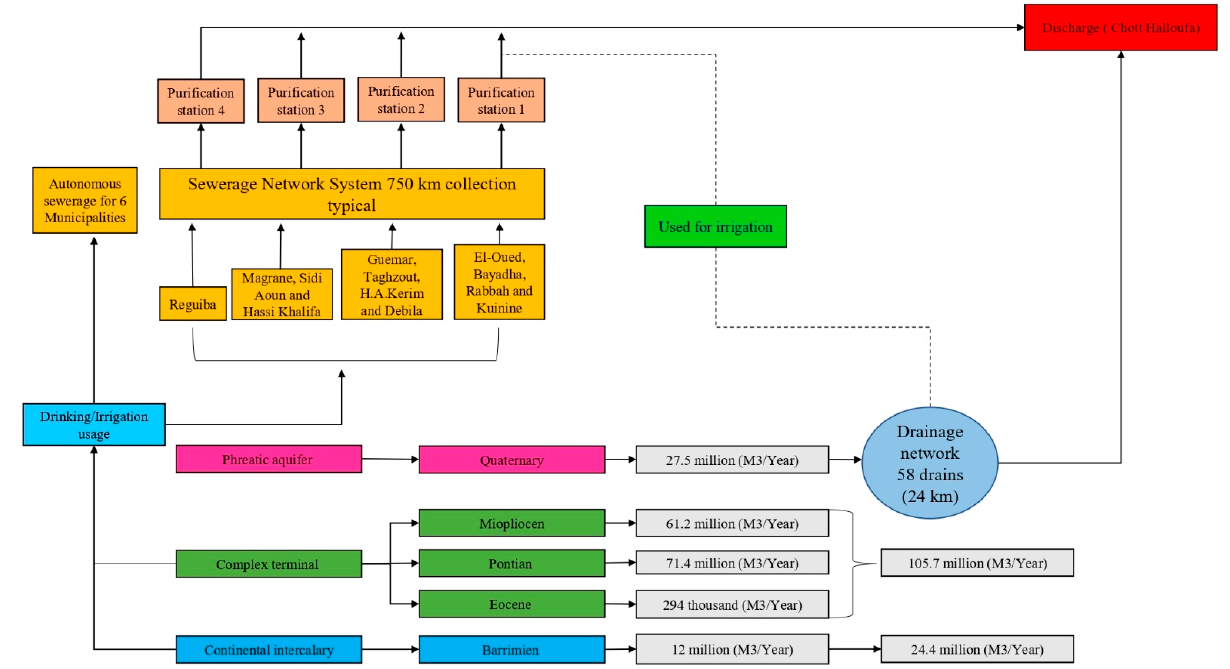
Figure 13. Groundwater exploitation, Sewerage, treatment of wastewater, evacuation, and drainage systems of the study area.